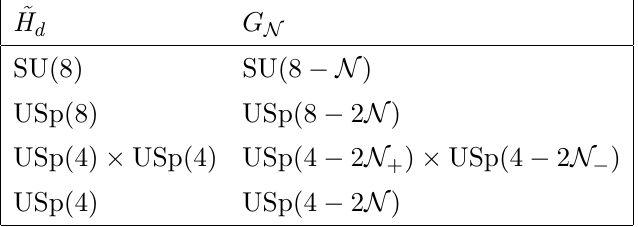
Table 2 . Maximal generalised structure subgroups G N (cid:26) ~H d preserving N supersymmetries in the truncated theory. Note that for d = 5 we have six-dimensional supergravity with ( N + ; N (cid:0)